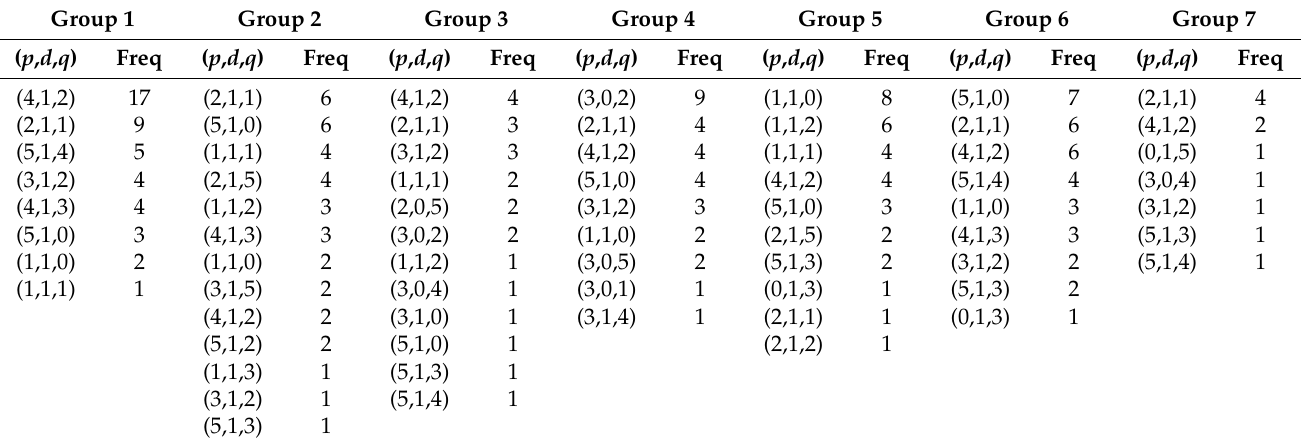
Table 5. Frequencies of ARIMA model results for solar power plants in each cluster.